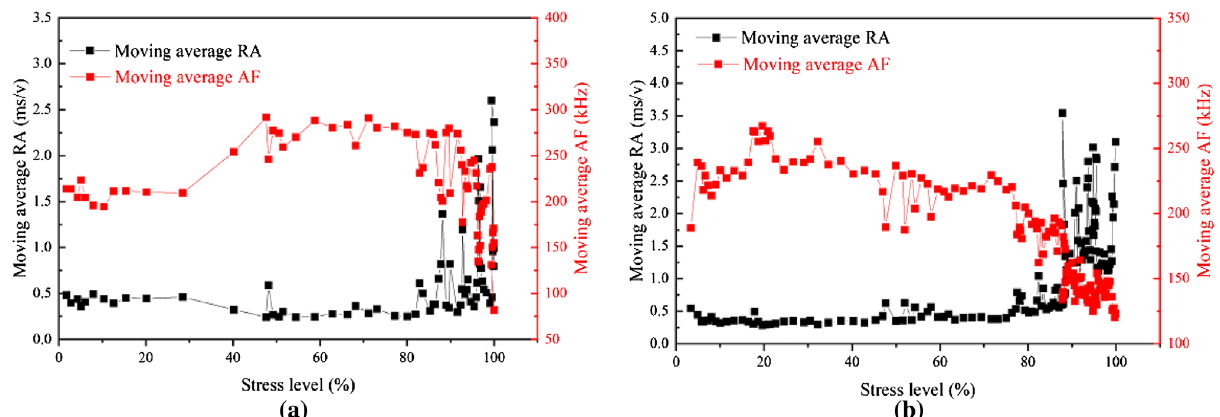
Figure 13. Changes in moving average RA and AF values during the loading. ( a ) Untreated; ( b ) 3.9 kW–10